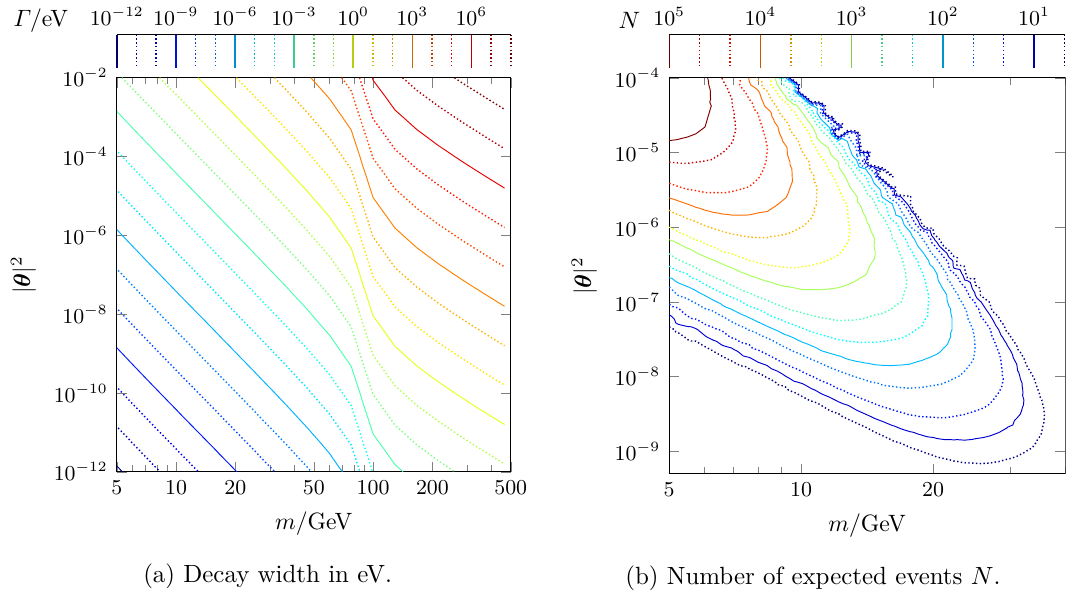
Figure 10 . Panel (a): scan over the decay width of the heavy neutrino as a function of its mass and the active-sterile mixing parameter displaced vertex events in the CMS detector for the HL-LHC with L = 3 ab − 1 and cuts as defined in section 6 . 1